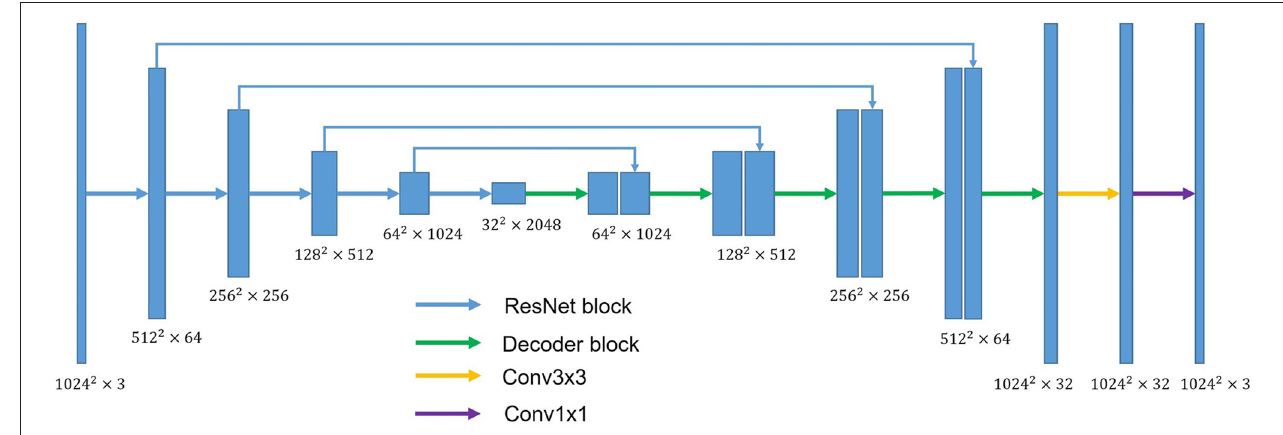
FIGURE 4 | The overall structure of the discriminator. ResNet block stands for the block used in ResNet-50. Conv3 × 3 indicates the 3 × 3 convolution layer. Conv1 × 1 indicates the 1 × 1 convolution layer. Decoder block mainly comprises a 3 × 3 convolution layer and 4 × 4 fractionally strided convolution layer. A pointwise convolution layer is used to connect them.